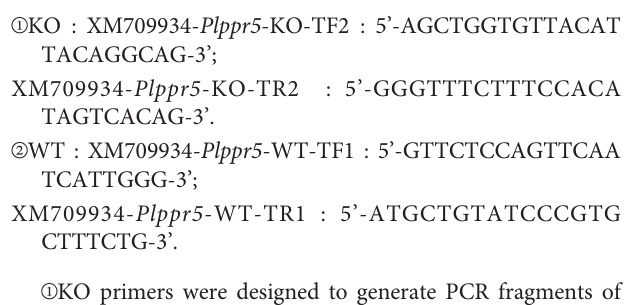
Figure 1A . A total of four positive F0 generation mice were obtained.